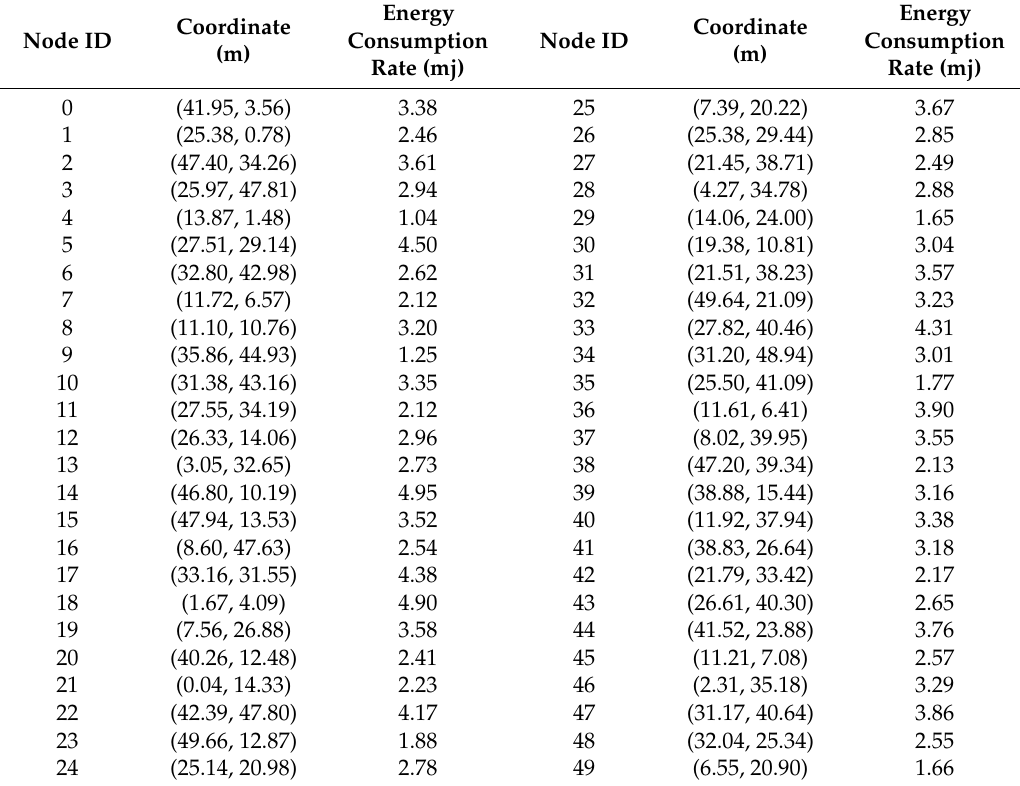
Table 3. Node coordinates and energy consumption rate.